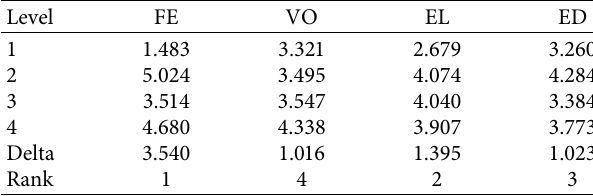
Figure 6: SR experimental results. Table 8: SN ratio response table on